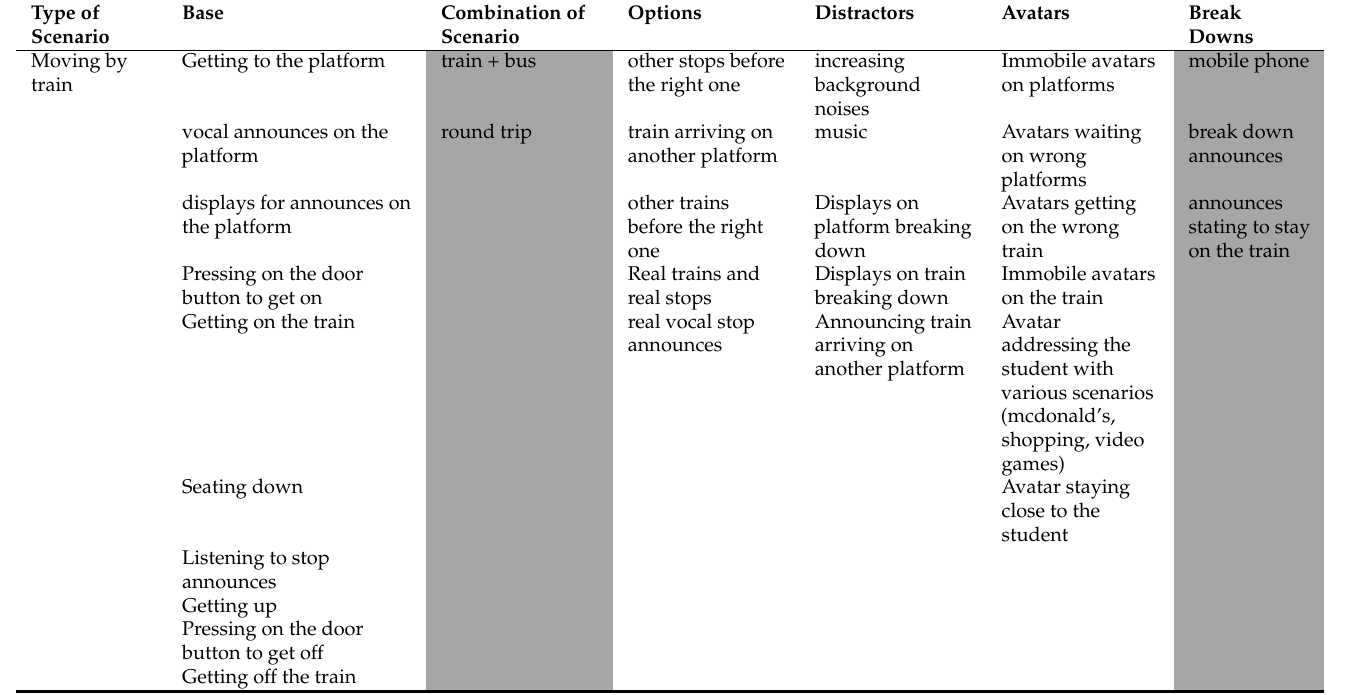
Table A3. Taking the train scenario variations.